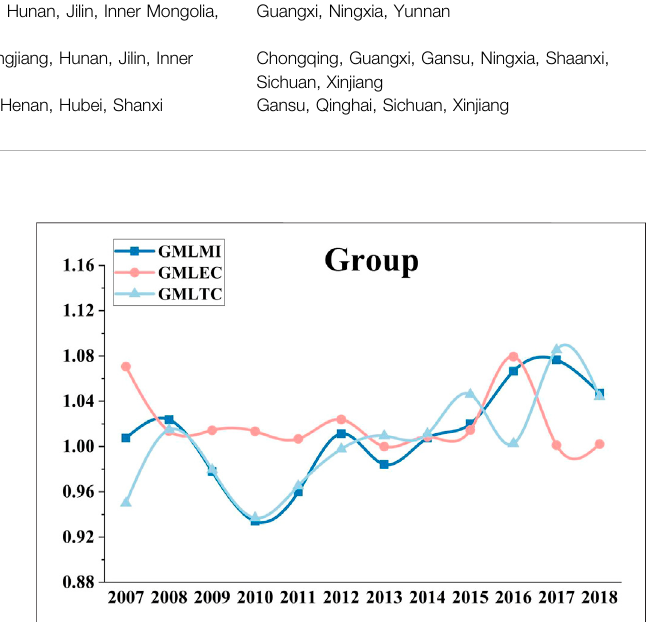
FIGURE 5 | GMLMI and its decomposition index under group Frontier from 2007 to